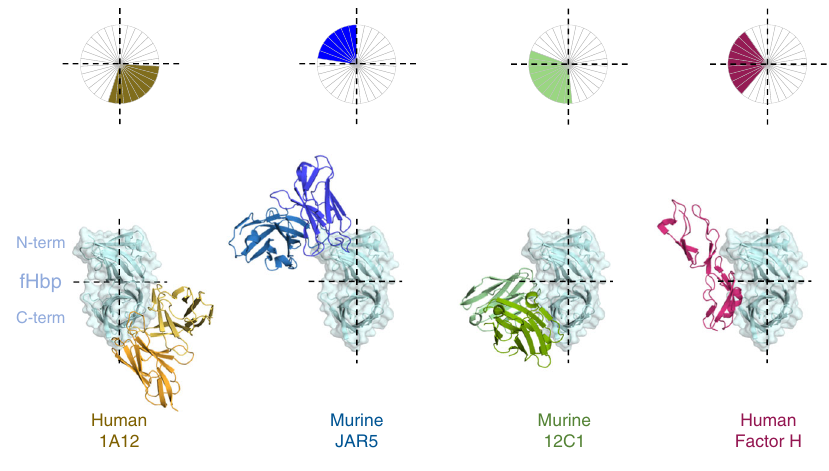
Fig. 3 Fab 1A12 shows a unique binding mode. Bottom: surface and ribbon representations of fHbp, bound to 1A12 (yellow), JAR5 (blue), 12C1 (green), and factor H (red). For clarity, only the Fab variable regions are shown. Top, schematic diagram of the different binding sites